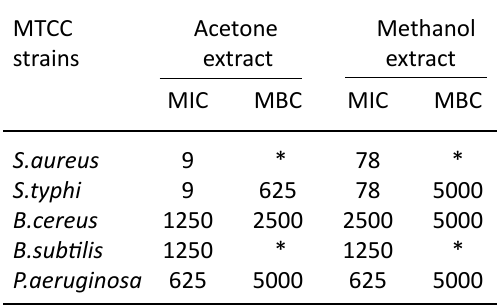
Fig. 8. Agar overlay bioautography of acetone extract of T.catappa leaf showing inhibition of P. vulgaris (Clinical isolate) at Rf values 0.71. 0.59 and Table 2. Minimum Inhibitory and Minimum Bactericidal